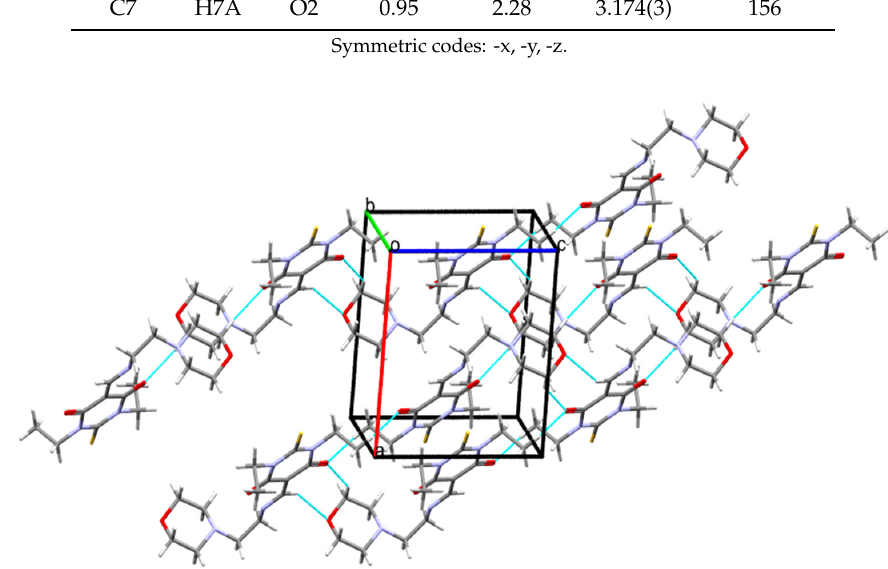
Figure 4. Crystal packing diagram of compound 2 . Table 4. The list of selected hydrogen bond Å in compound 3 .